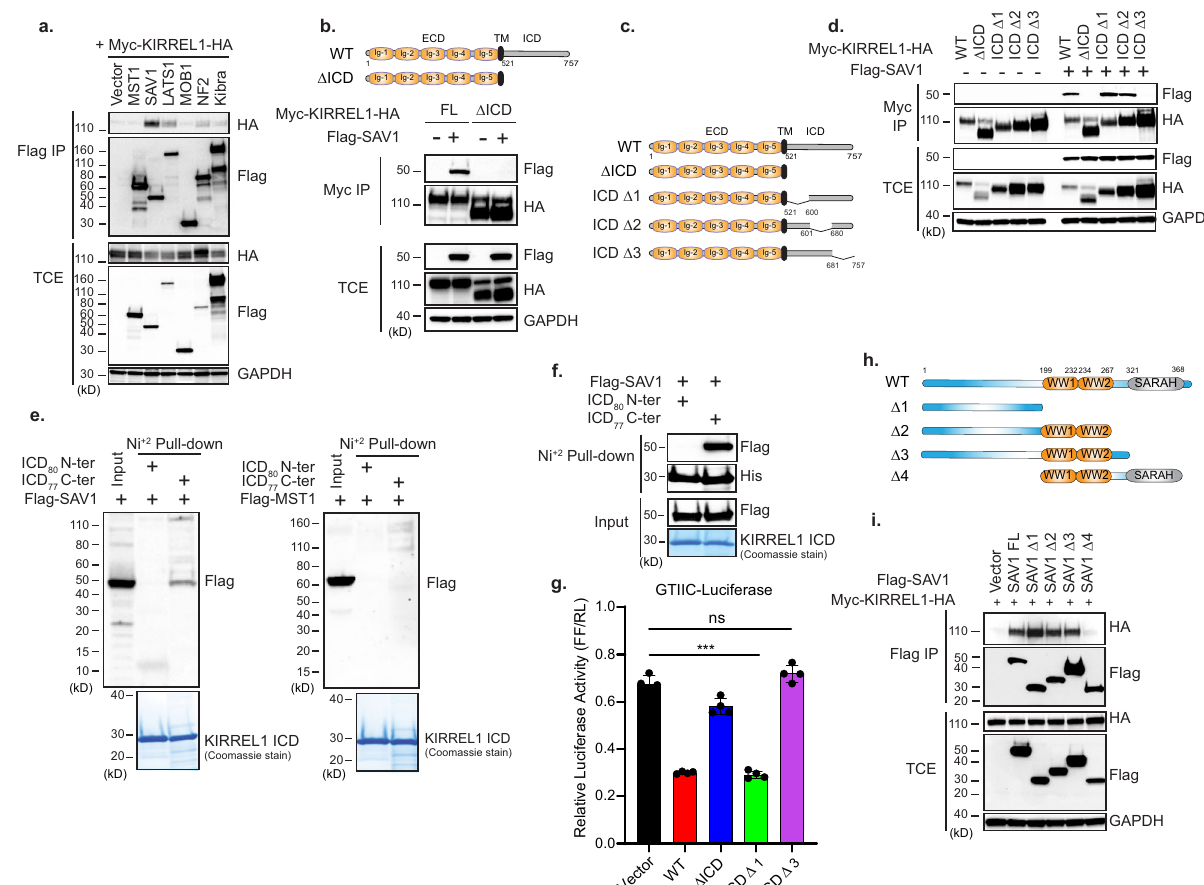
Fig. 3 KIRREL1 interacts with N-terminal of SAV1 through its intracellular domain (ICD). a KIRREL1 interacts with SAV1 in co-immunoprecipitation assay. HEK293T cells were co-transfected with plasmids encoding Myc-KIRREL1-HA and Flag-tagged Hippo pathway components, and cell lysates were subjected to co-immunoprecipitation assay. TCE total cell extract. b Full-length KIRREL1 but not the Δ ICD mutant interacts with SAV1 in co-immunoprecipitation assay. c Schematic of full-length and ICD deletion mutants of KIRREL1. d Full-length, ICD Δ 1, and ICD Δ 2 but not ICD Δ 3 mutant of KIRREL1 interacts with SAV1 in co-immunoprecipitation assay. e The C-terminal fragment of KIRREL1 ICD interacts with SAV1. Puri fi ed recombinant His-SUMO-tagged KIRREL1 N-terminal fragment of ICD (ICD 80 — a.a 521 – 600) or C-terminal fragment of ICD (ICD 77 — a.a 681 – 757) was incubated with cell lysates expressing ectopic Flag-tagged SAV1 (left panel) or MST1 (right panel) and subjected to Ni-NTA pull-down. Bottom panel shows Coomassie-stained gel of puri fi ed KIRREL1 ICD fragments. f The C-terminal fragment of KIRREL1 ICD directly interacts with SAV1. Puri fi ed recombinant His-SUMO-tagged KIRREL1 N-terminal fragment of ICD (ICD 80 — a.a 521 – 600) or C-terminal fragment of ICD (ICD 77 — a.a 681 – 757) was incubated with puri fi ed Flag-SAV1 and subjected to Ni- NTA pull-down assay. Coomassie-stained gel shows puri fi ed HIS-SUMO-tagged KIRREL1 ICD fragments. g Overexpression of KIRREL1-induced inhibition of GTIIC-luciferase activity requires the C-terminal fragment of KIRREL1 ICD. Experiment was performed as in Fig. 2e. The data represent mean ± SD, n = 4, error bars denote the SD between four biological replicates; unpaired two-tailed t -test was used to determine the statistical signi fi cance, *** p value < 0.001, ns — 0.1346. h Schematic of full-length and deletion mutants of SAV1. i N-terminal fl exible domain of SAV1 is required and suf fi cient for binding with KIRREL1. HEK293T cells were transfected with plasmids encoding KIRREL1 and indicated SAV1 mutants and subjected to co-immunoprecipitation